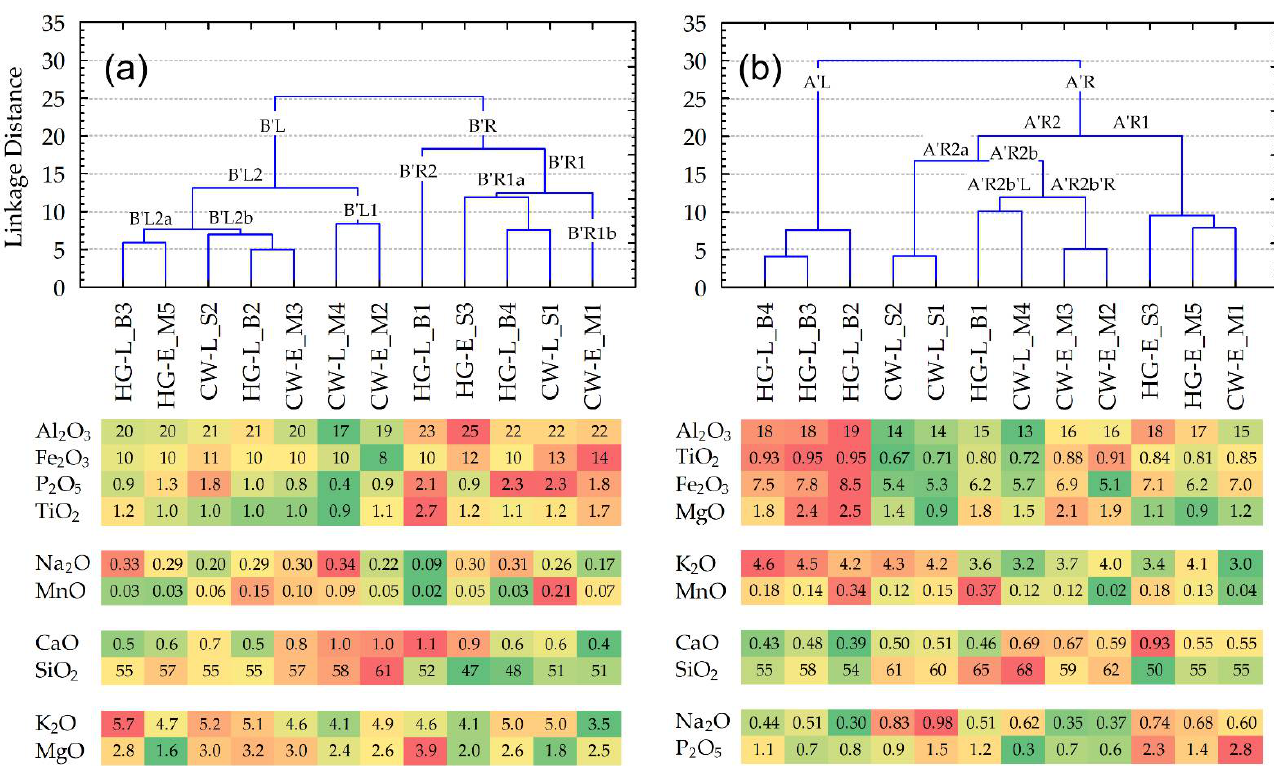
Figure 8. Dendrograms of the pottery samples (clustering using Ward’s method by calculating the Manhattan (City Block linkage distances), compiled using the content of the major elements: ( a ) panel—in the clay matrix; ( b ) panel—in the bulk composition. The bottom of both panels presents conditionally formatted color scales, the individual content of the major analytes, recalculated by stoichiometry as oxides (%). The sequences in the analyte groups correspond to the elemental cluster diagrams for the Figure 3a,b panels.